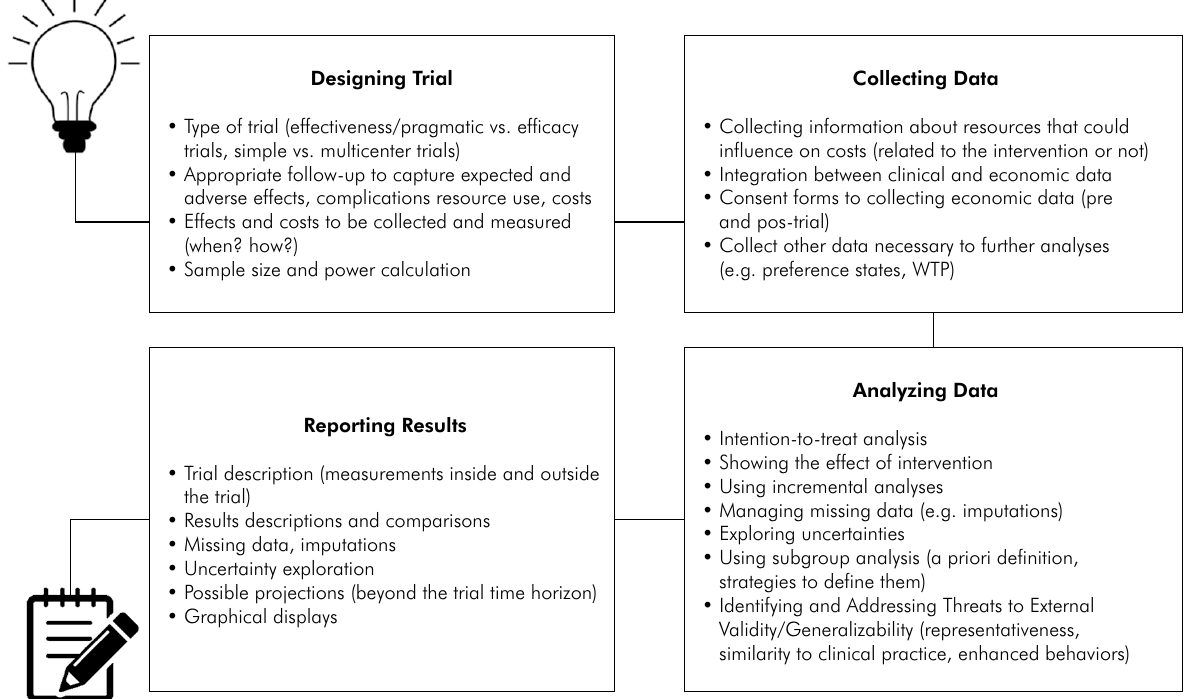
Figure 6. Schematic process summarizing important points from the idea to the protocol, according to ISPOR Good Research Practices Taskforce for economic